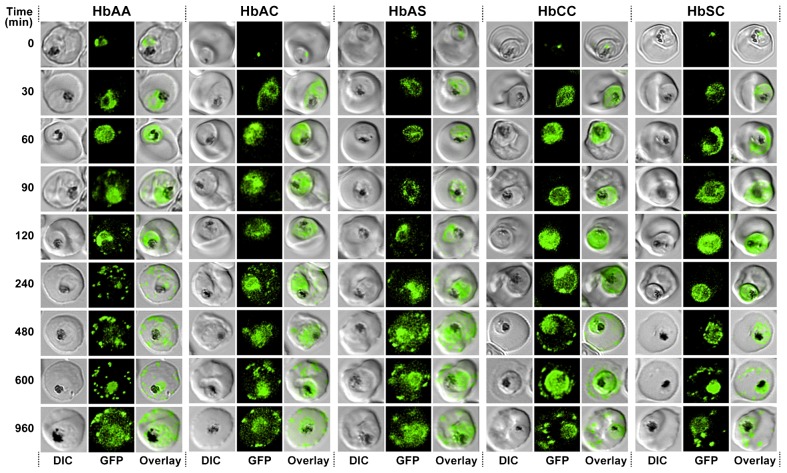
Kinetics of export of PfSBP1CAD in various P. falciparum-infected erythrocytes.P. falciparum-infected erythrocytes were taken from culture at the time points indicated after the addition of the anti-aggregation ligand and immediately analyzed by live cell confocal fluorescence microscopy. Tightly synchronized cultures at the trophozoite-stage (18–22 h post invasion) were used. Images shown are representative examples for the export phenotypes that were used for later quantification.